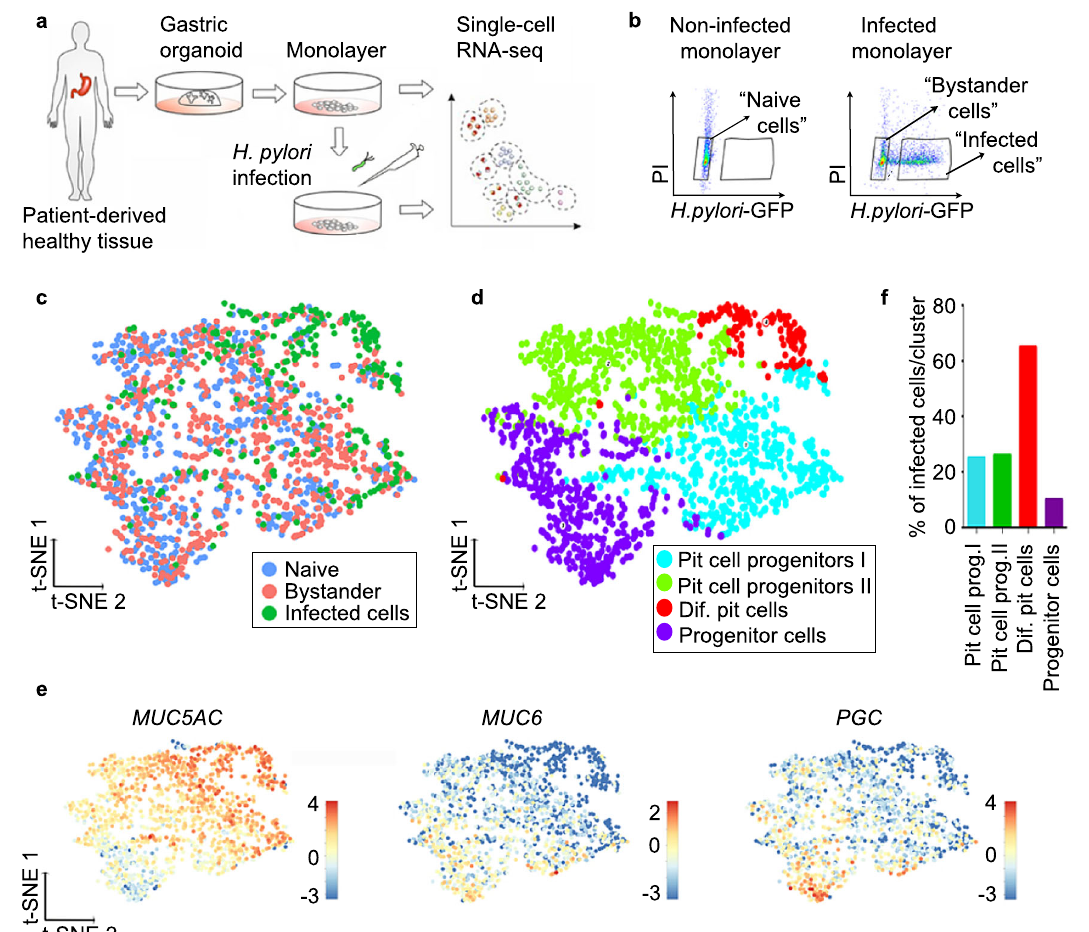
Fig. 2 | scRNA-seq reveals that H. pylori binds to a subpopulation of pit cells. a Schemeoftheexperimentalsetup.Gastricorganoidsweregeneratedfromgastric healthy tissue and used to obtain 2D monolayers. Monolayers were infected with GFP-expressing H. pylori (MOI 1) for 6h and subjected to scRNA-seq. b Repre- sentative fl ow cytometry dot plots of naïve and infected monolayers. Cells were gated as indicated based on GFP signal ( H. pylori ) and propidium iodide (PI) and subjected to scRNA-seq. c Single-cell transcriptomes from the different gates